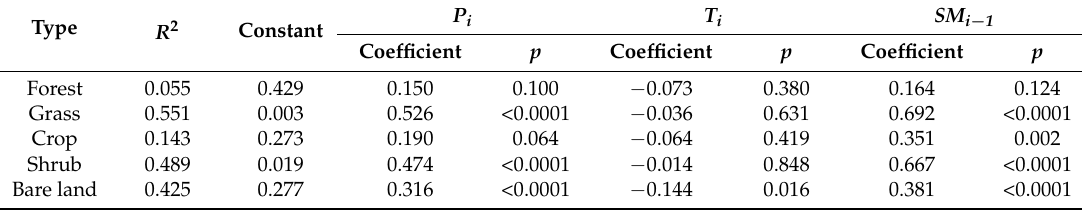
Table 1. The results of multiple linear regression analysis between soil moisture and climate